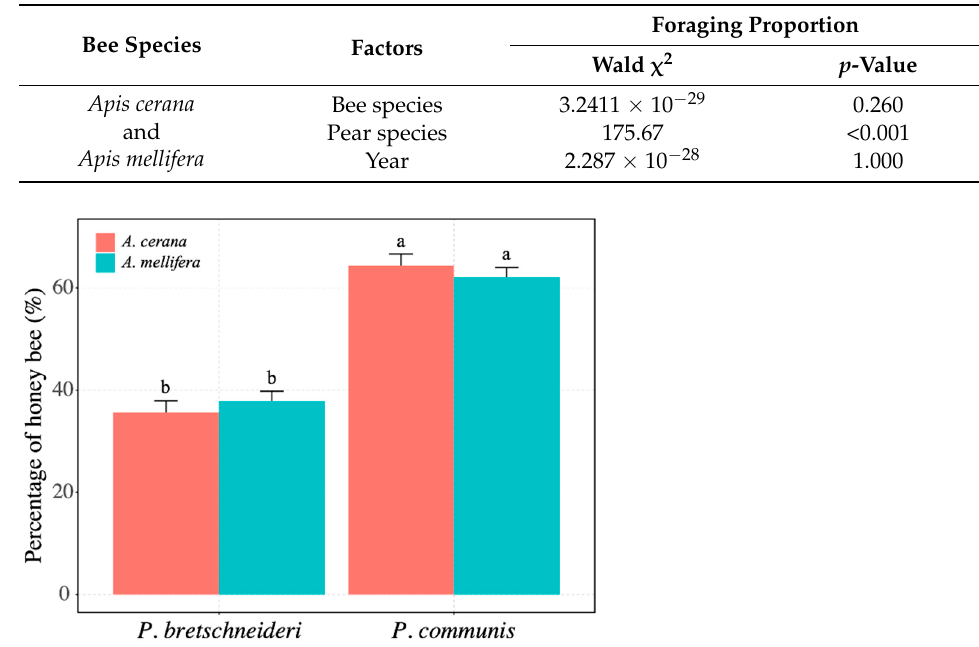
Table 1. Generalized linear model (calculated Wald χ 2 and p value) of the effect of bee species ( A. cerana and A. mellifera ), pear species ( P. bretschneideri and P. communis ) and year on single pear flower foraging proportion.